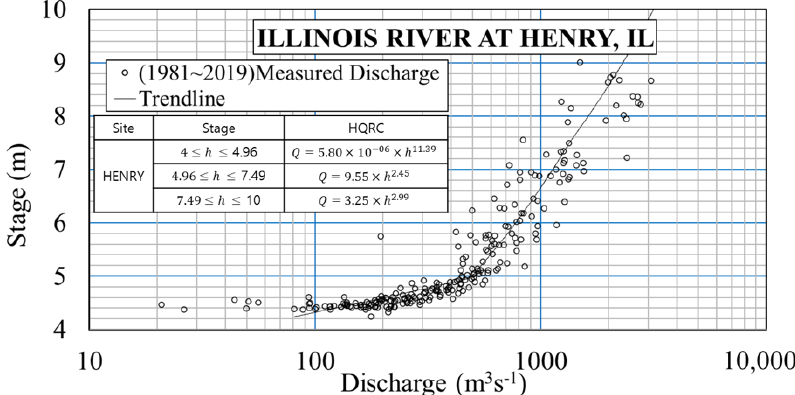
Figure 9. Surrogate HQRC rating constructed using the calibration and validation measurements for supporting the IVRC station operation.